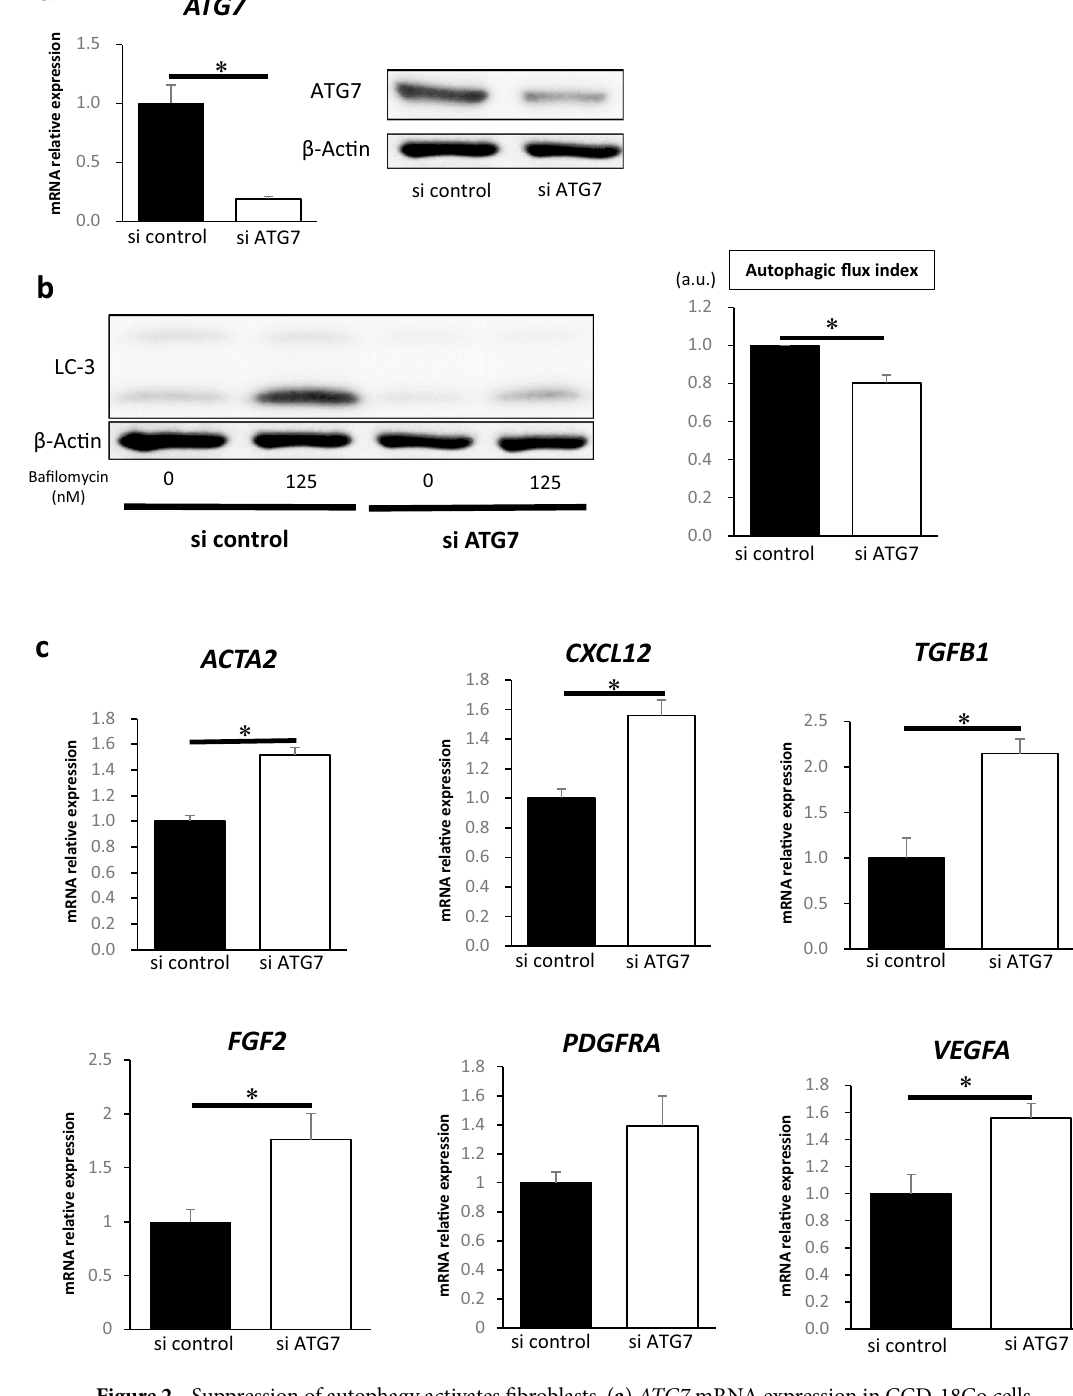
Figure 2. Suppression of autophagy activates fibroblasts. ( a ) ATG7 mRNA expression in CCD-18Co cells transfected with ATG7 or control siRNA analysed using quantitative real-time PCR (qRT-PCR) (left; n = 3, mean ± SD, *P < 0.05). The expression of ATG7 protein in CCD-18Co cells transfected with ATG7 or control siRNA analysed using western blotting (right). ( b ) Western blotting and autophagic flux assays in CCD-18Co cells transfected with ATG7 or control siRNA ( n = 4, mean ± SD, *P < 0.05). ( c ) Relative expressions of ACTA2, CXCL12, TGFβ1 , FGF2, PDGFRA and VEGFA mRNA in CCD-18Co cells transfected with ATG7 or control siRNA analysed using qRT-PCR ( n = 3, mean ± SD, *P < 0.05). ( d ) Cell numbers of HCT116 cells co-cultured with CCD-18Co cells transfected with ATG7 or control siRNA for 24, 48 and 72 h. ( n = 3, mean ± SD, *P < 0.05). ( e ) Relative expressions of ACTA2, CXCL12, TGFβ1, FGF2, PDGFRA and VEGFA mRNA in CCD-18Co cells treated with pepstatin or control ( n = 3, mean ± SD, *P < 0.05). Protein expression levels were measured using imageJ software 1.8.0_172 (https:// imagej. nih.